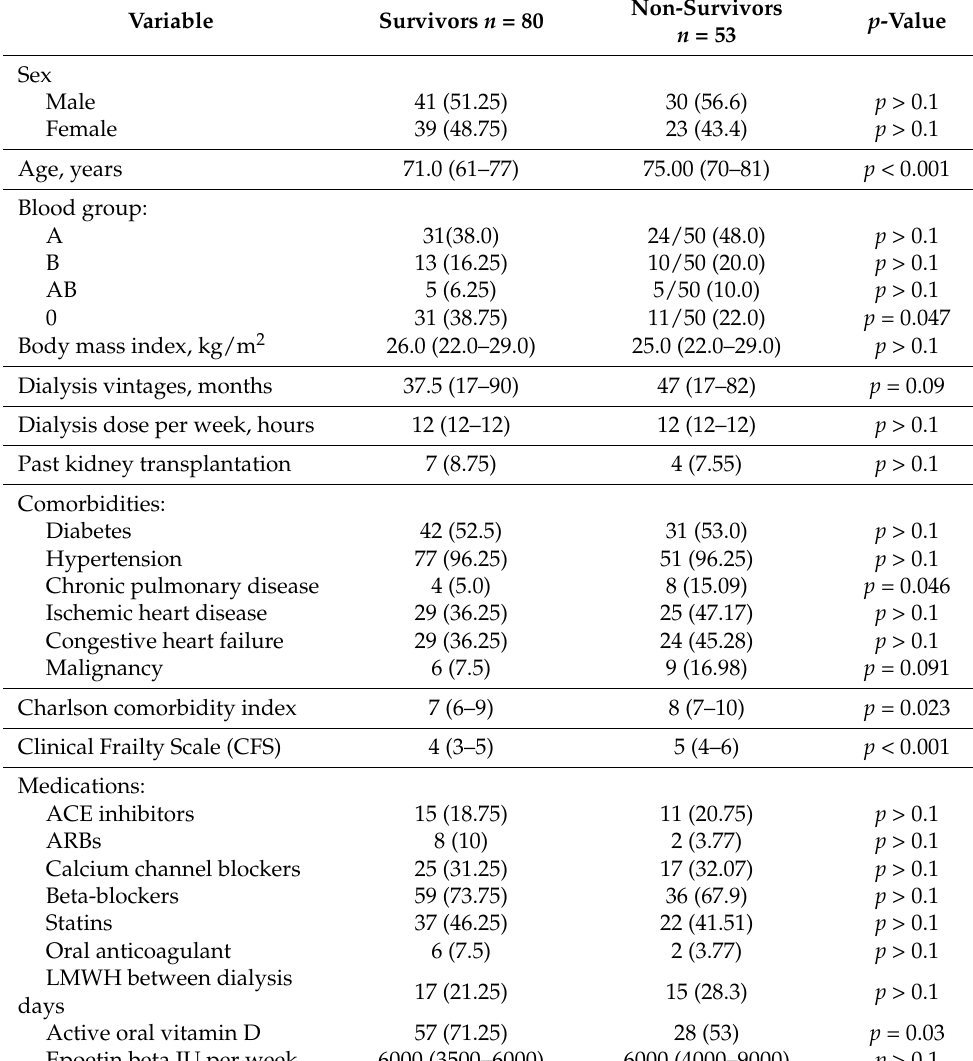
Table 2. Demographic and baseline characteristics of HD patients with COVID-19 by patient outcome.